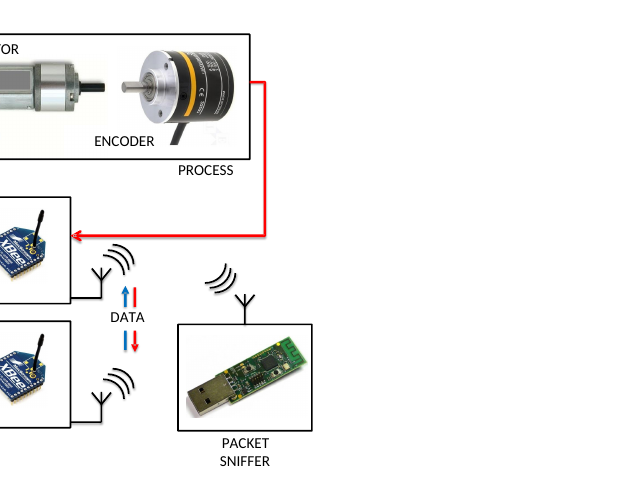
Figure 2. Scenario to perform the tests, in blue the control signal and in red the feedback of the plant.